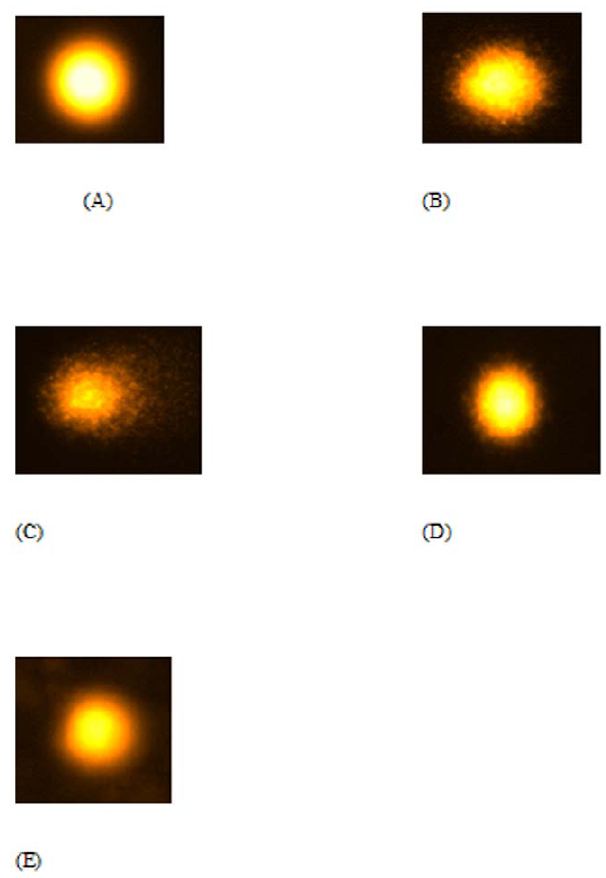
Figure 1. Showing the average comet picture of kidney from different treated groups of mice. Average comet picture of kidney samples of various treated mice groups divided as (A) Control as Group I (B) Riboflavin treated as Group II (C) Cisplatin treated as Group III (D) Combination I as Group IV (E) Combination II as Group V.